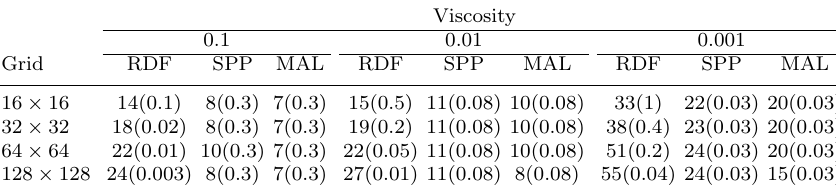
Table 5. Number of GMRES(20) iterations with the RDF, MAL and SPP preconditioners for steady Oseen problems (Q2-P1 FEM stretched grids), the optimal parameters τ , α , γ found experimentally.